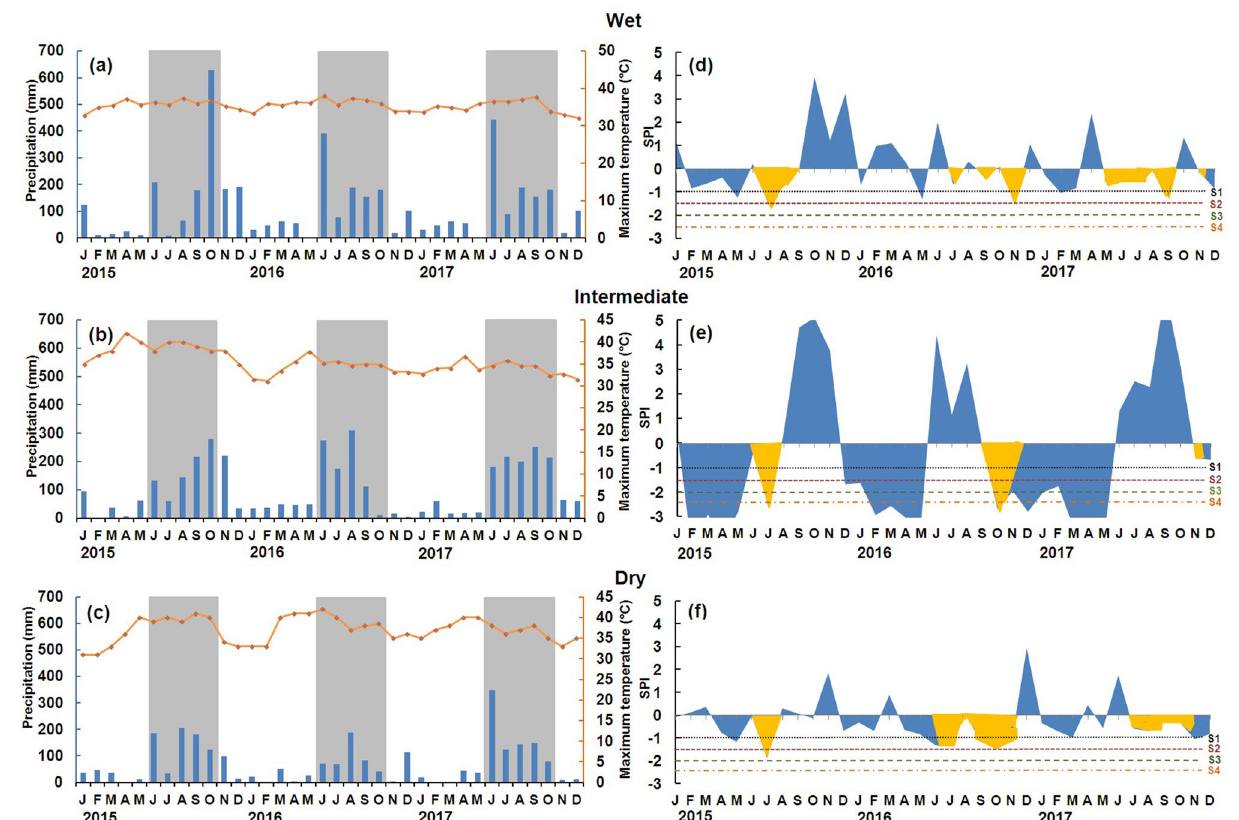
Figure 1. Environmental characterization recorded from 2015 to 2017 in the Yucatan Peninsula. Total annual precipitation and means of monthly temperature ( a – c ). The bars indicate precipitation, and the continuous line indicates temperature. The rainy season is indicated by grey shading. Monthly standardized precipitation index ( d – f ), Shaded in yellow indicates canícula . S1: mild drought, S2: moderate drought, S3: severe drought, S4: extreme